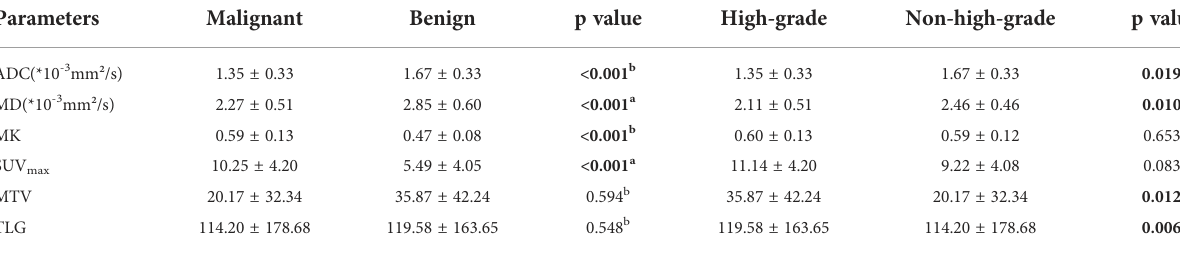
TABLE 2 Comparison of different parameters among different